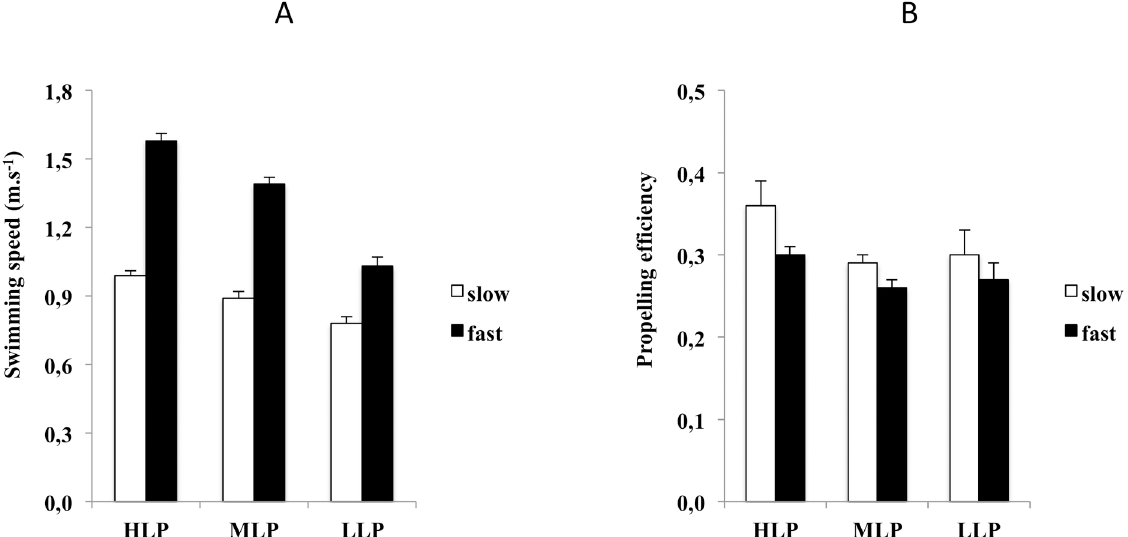
Fig 1. A and B: Swimmingspeed(m . s -1 ) (Panel A) and propellingefficiency (Panel B) in the three groups of swimmers ([HLP] high- level performers; [MLP] middle-levelperformers; [LLP] low-levelperformers) at slow (white columns) and fast (black columns) pace. Data are means ±